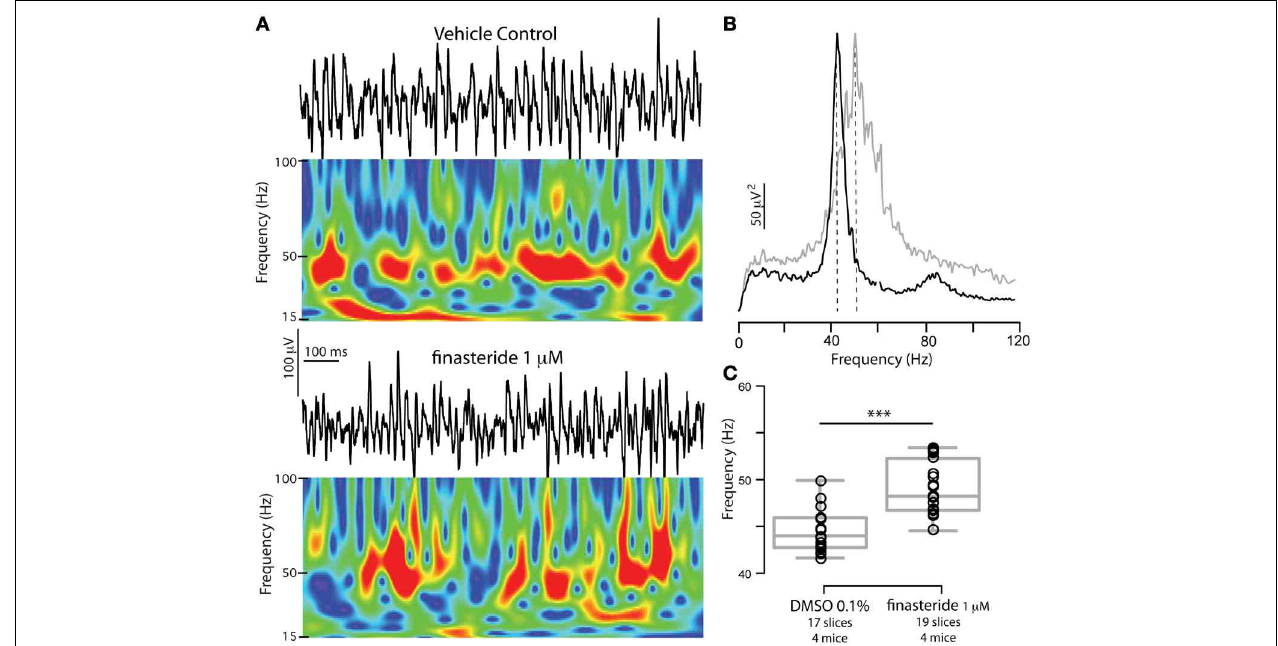
FIGURE 7 | Blocking neurosteroidogenesis increases γ oscillations frequency in slices from WT mice. (A) Representative 1s epoch of local field potential oscillations and corresponding Morlet Wavelets in the CA3 region of hippocampal slices obtained from a WT adult male mouse in vehicle (DMSO 0.01%) or in 1 μ M finasteride (after 30min incubation). (B) Power spectral densities of the same recordings (average of 180s) for DMSO 0.01% (black) and finasteride (gray). (C) Peak frequencies of γ oscillations recorded